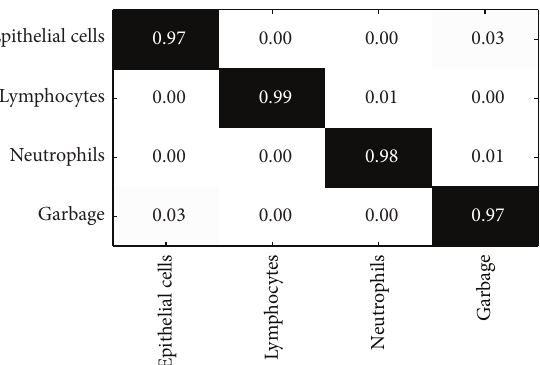
Figure 5: The confusion matrix of the percentages of correct recognition. 𝑥 -axis represents the predicted cell types. 𝑦 -axis is correct cell types. The values in black are the percentages of correct recognition. The values in grey are the percentages of incorrect